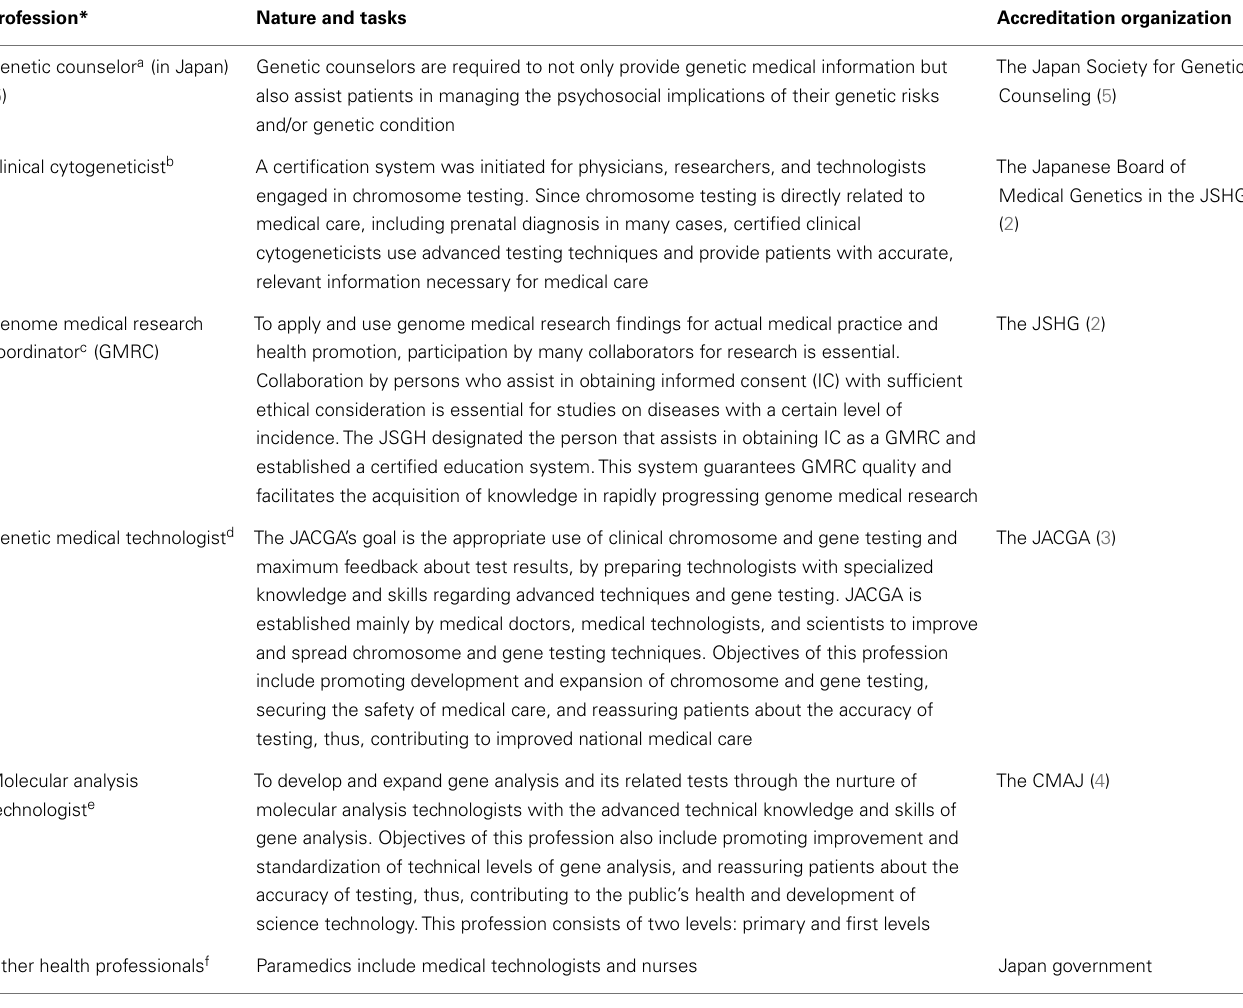
Table 1 | Professions certified to engage in chromosome and gene testing and/or genetic counseling in Japan